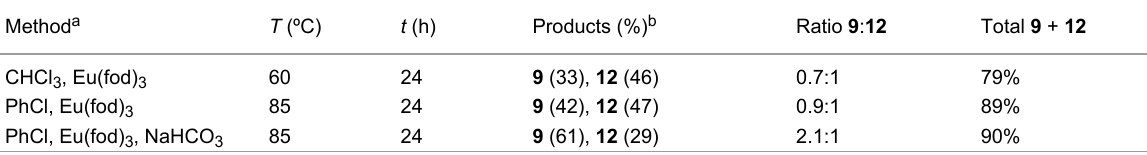
Table 1: Rearrangement of 5- O -prenylflavone 8